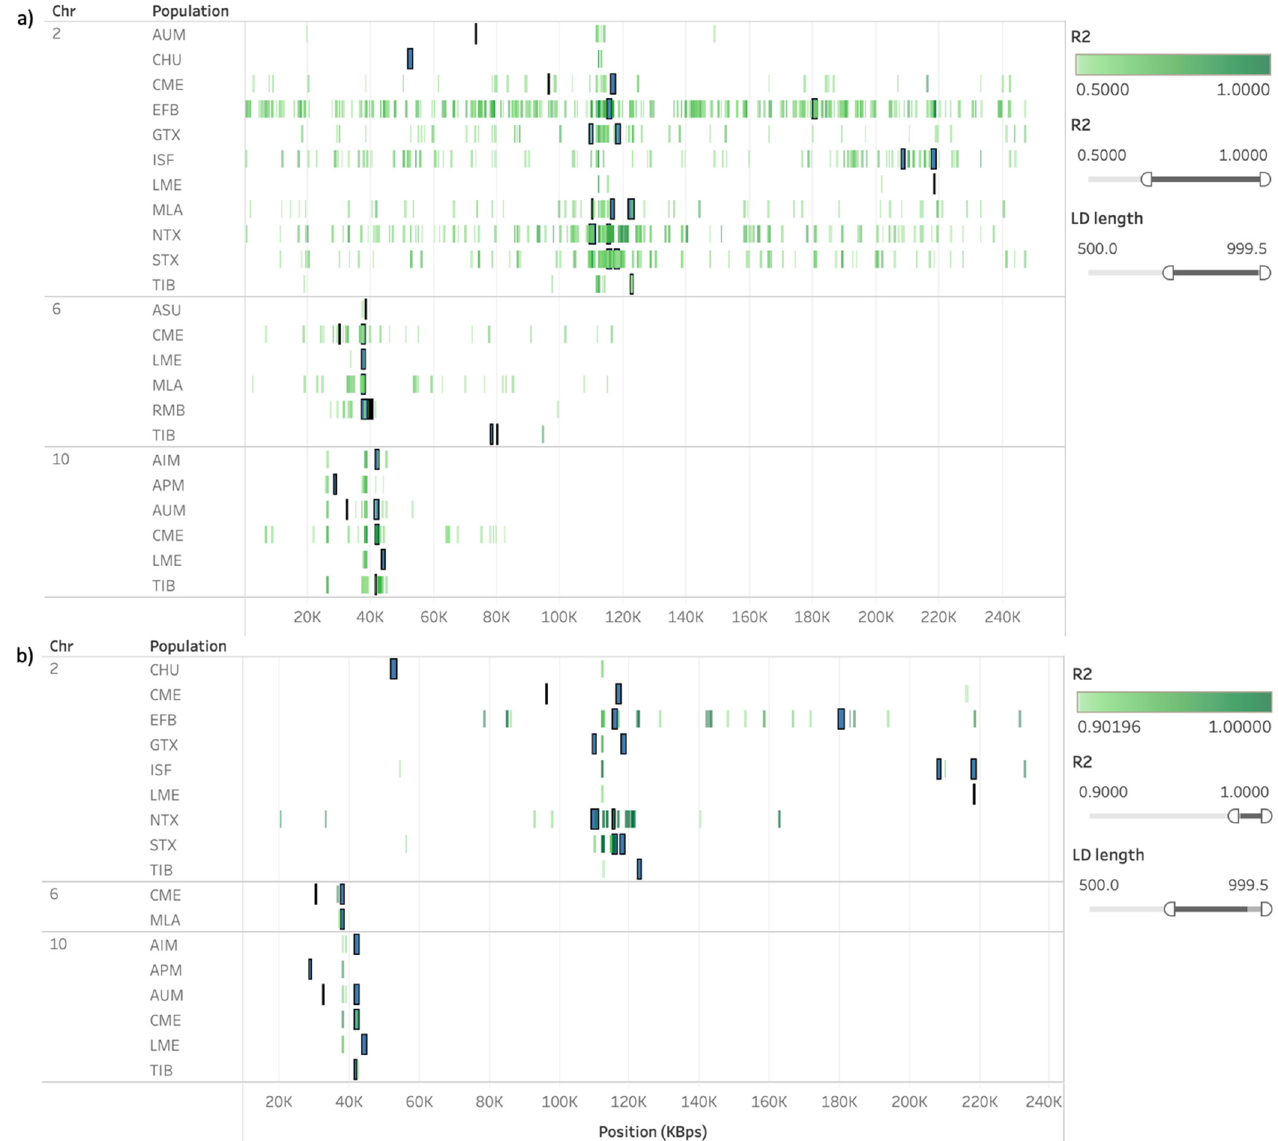
Figure 5. Runs of homozygosity (ROH) islands (blue) plotted against SNP pairwise calculation of r 2 (green) in chromosomes where common regions in ROH islands were detected for more than one sheep population. Regions in linkage disequilibrium (LD) were restricted to SNP distances between 500 and 1000 kb, and r 2 > 0.5 ( a ) or r 2 > 0.9 ( b ). Only rows where both ROH islands were present and LD met the thresholds were presented, as a default and immutable requirement of Tableau’s visualization.